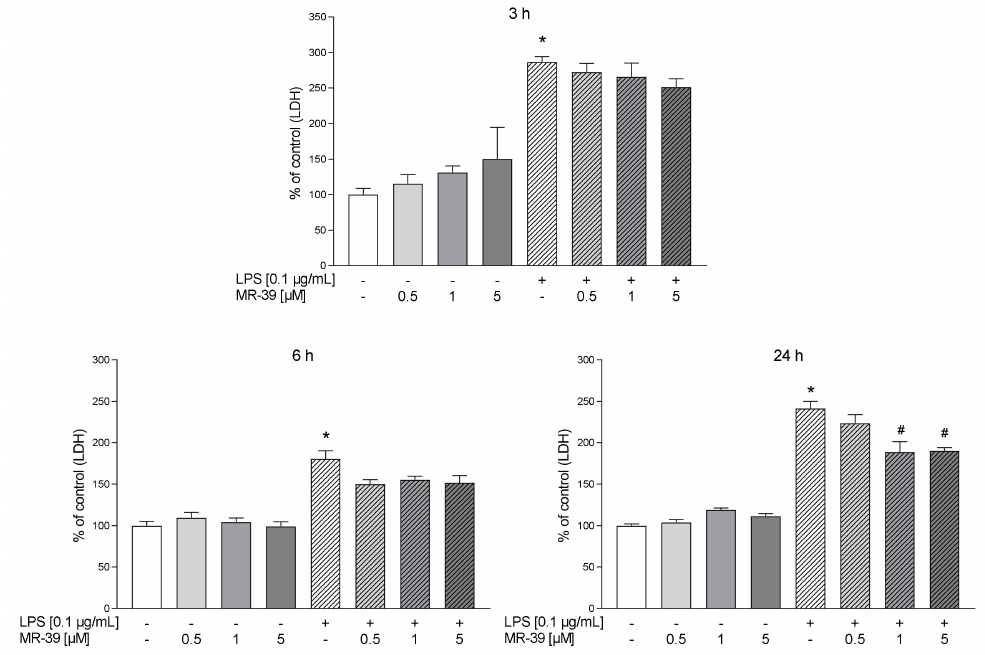
Figure 3. The impact of MR-39 on LPS-induced LDH release in rat microglial cultures. The cells were preincubated with MR-39 (0.5–5 µ M) for 1 h and then treated with 0.1 µ g/mL LPS for 3, 6, and 24 h. Control cultures were treated with the appropriate vehicle. The data are presented as the mean ± SEM percentage of the control (vehicle-treated cells) from independent experiments, n = 2–5 in each experiment. * p < 0.05 vs. control group, # p < 0.05 vs. LPS group. LPS–lipopolysaccharide; LDH–lactate